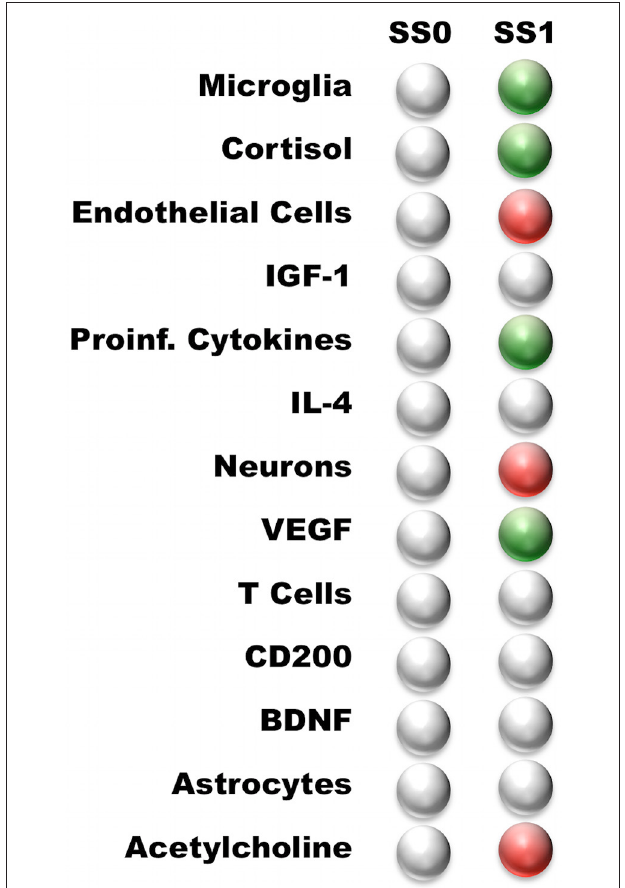
FIGURE 2 | Steady states predicted by the neuro-immune model. White—nominal state (0); Green—high state (1); Red—low state ( − 1). The steady states are named according to their profile: Typical Health, and Neuroinflammation. Typical Health state is shown for reference.